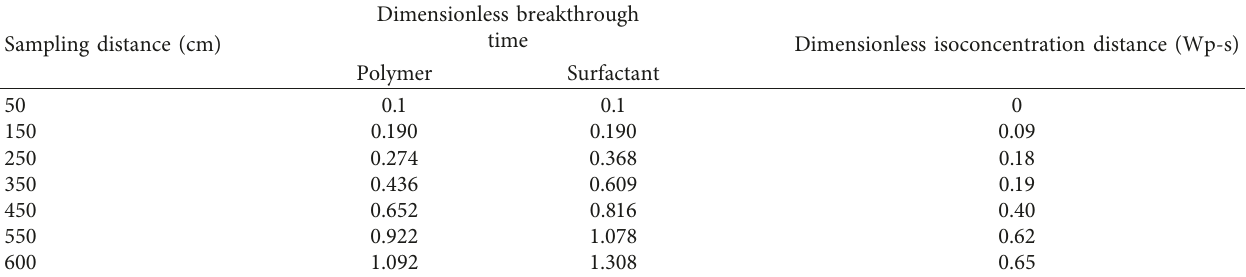
Table 3: Dimensionless breakthrough time and isoconcentration distance of chemical agents (sampling loss volume is deducted). Dimensionless Sampling distance (cm)